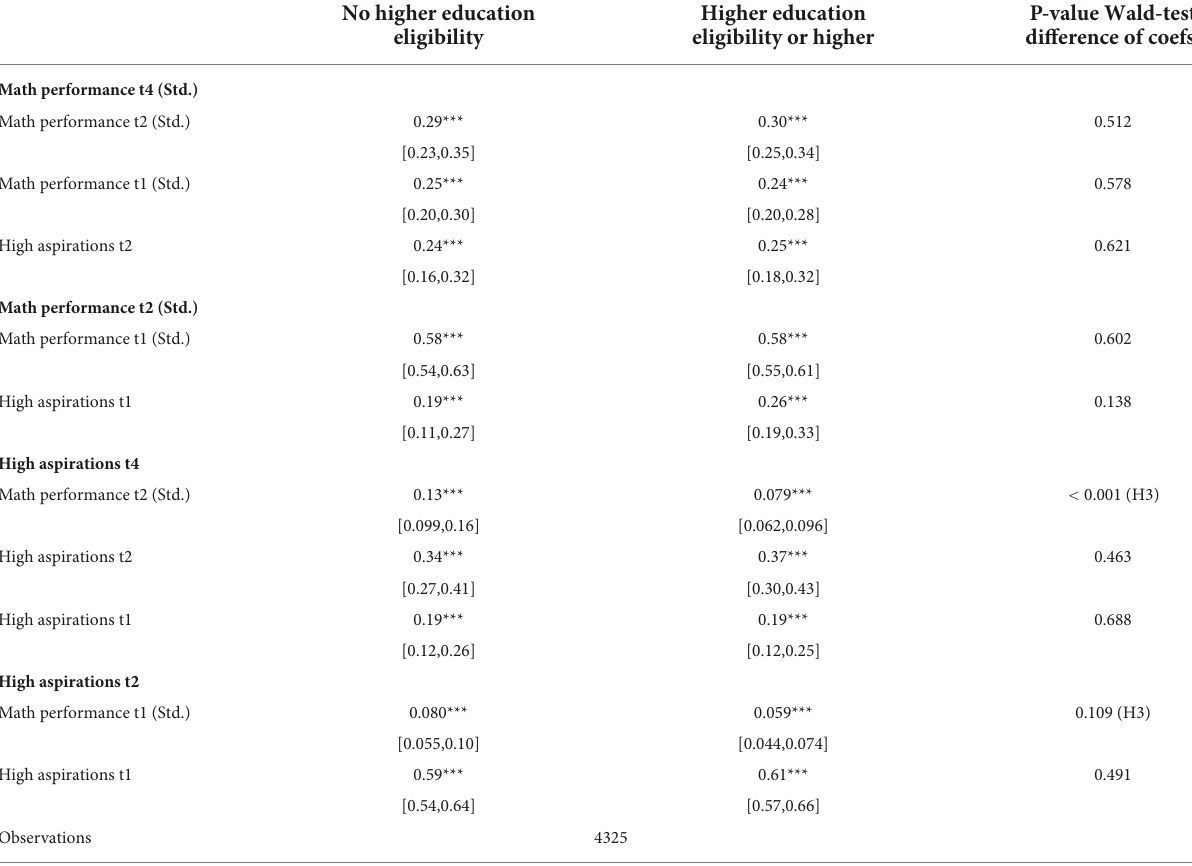
TABLE 2 Structural equation modeling path coefficients by parental level of education.